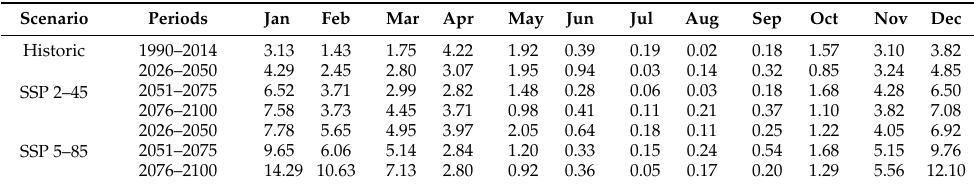
Table 8. Ensemble of the number of days in a month having a daily average flow rate greater than the Q5% (exceedance percentile) of each